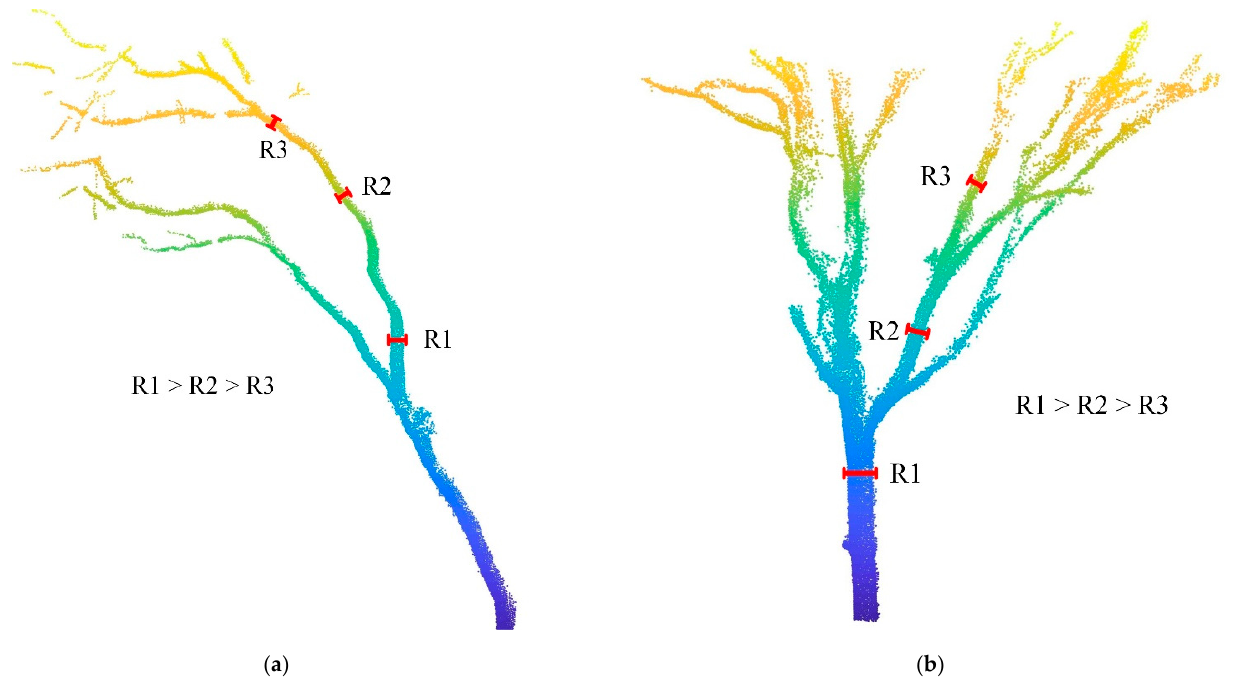
Figure 9. Variation in diameter of branches under natural conditions. ( a ) Variation in diameter of one branch; ( b ) variation in diameter of different